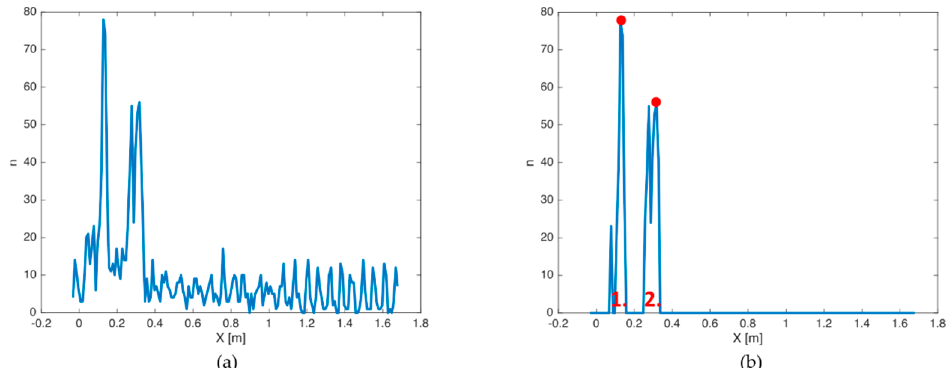
Figure 6. X-axis histogram: ( a ) Original histogram; ( b ) Result of Equation (5) applied on this figure ( a )